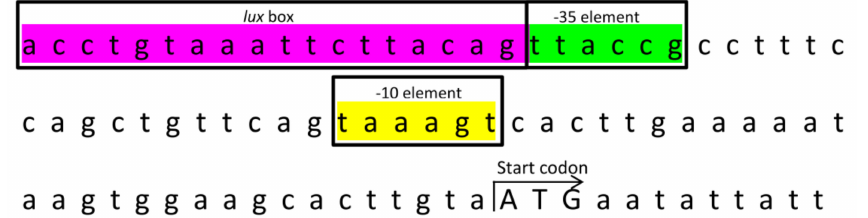
Figure 5. Schematic diagram of the upstream region of abaI . The start codon of the gene is labelled in uppercase. Promoter elements were highlighted in colors. Yellow, − 10 (Pribnow box); Green, − 35; Magenta, lux